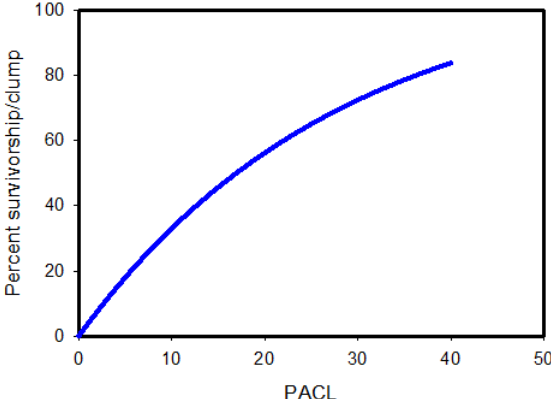
Figure 2. Percent survivorship per redwood clump over a five-year period and the percent above canopy light (PACL). Sprout mortality increases with declining light regime (adapted from [35]).